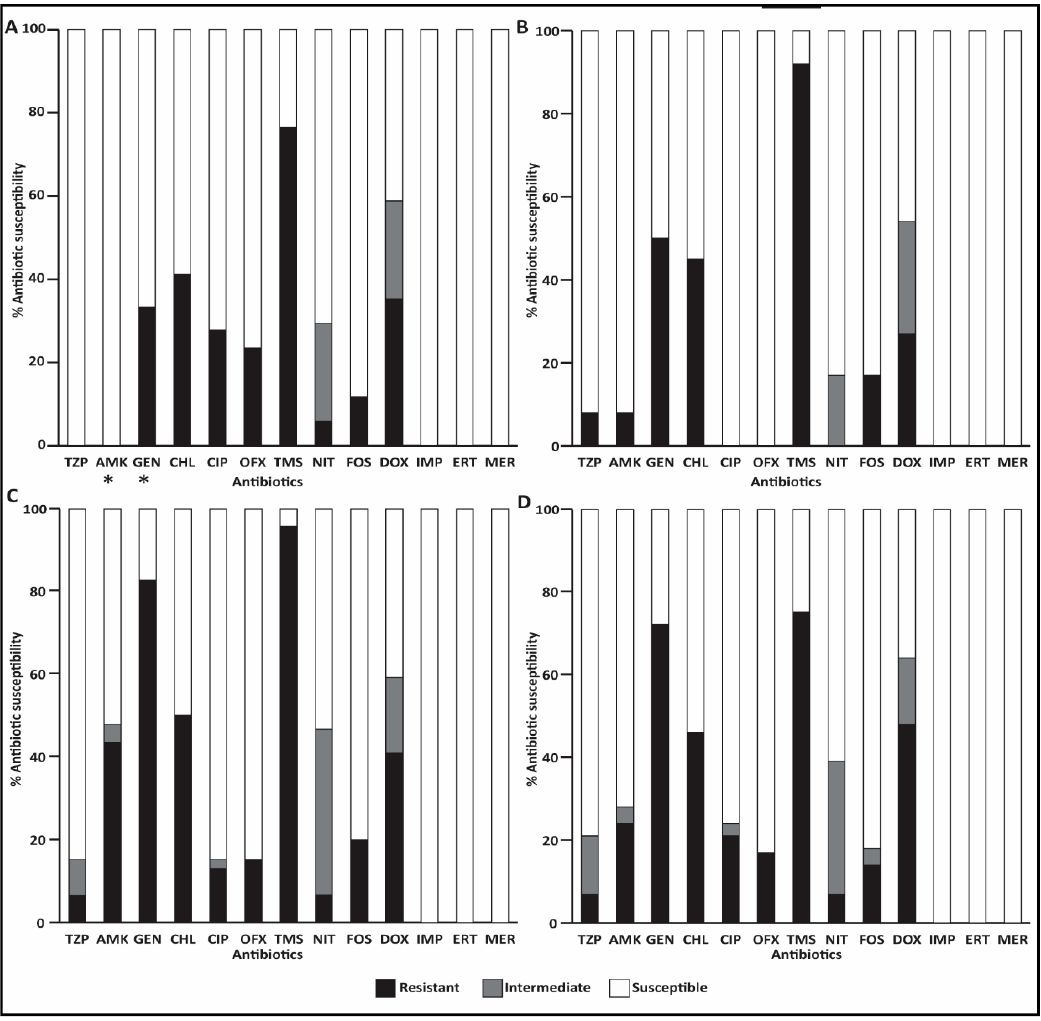
Figure 2. Antibiotic susceptibility profiles of ESBL-E shed on admission; foals ( A , n = 18 isolates) and mares ( B , n = 11 isolates); and 72 h post admission, foals ( C , n = 46 isolates) and mares ( D , n = 29 isolates). Significant changes are marked with asterisks.